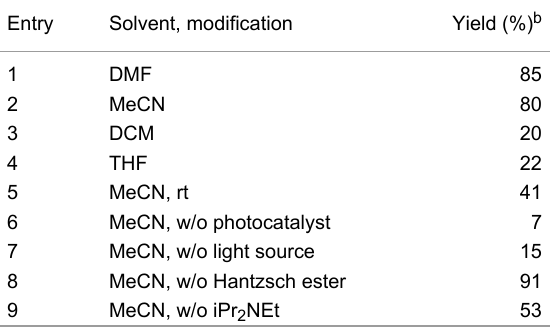
Table 2: Solvent/temperature dependence and control experiments of deoxygenation reaction with 3,5-bis(trifluoromethyl)benzoate 3 a